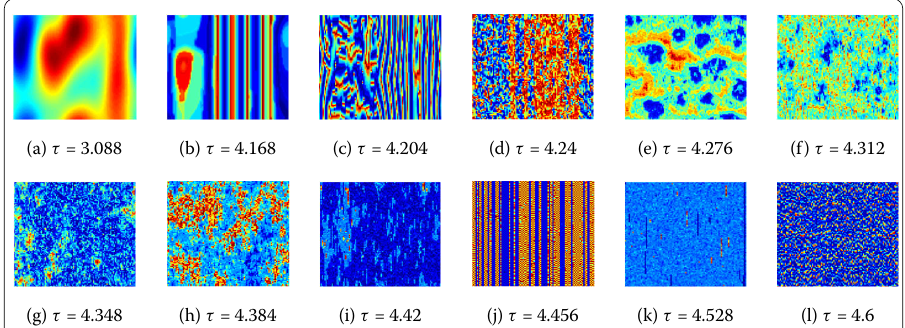
Figure 3 Pattern self-organization and transition on the route to chaos with the variation of τ covering [2.8,4.6]. t = 20,000, the parametric conditions are the same as those in Fig. 1. The initial conditions are given by (25a)–(25b) and are exactly the same for each pattern graph. The advection direction is from up to down. These conditions are also the same for all the pattern simulations